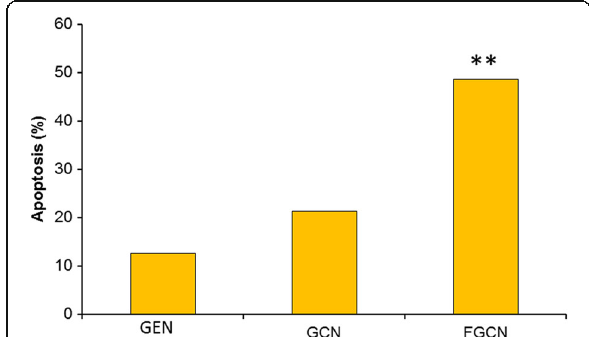
Fig. 8 Apoptosis analysis of HeLa cancer cells after treatment with GEN, GCN, and FGCN. Flow cytometer was used to analysis the proportion of cell apoptosis. ** p < 0.01 is the statistical difference between FGCN and